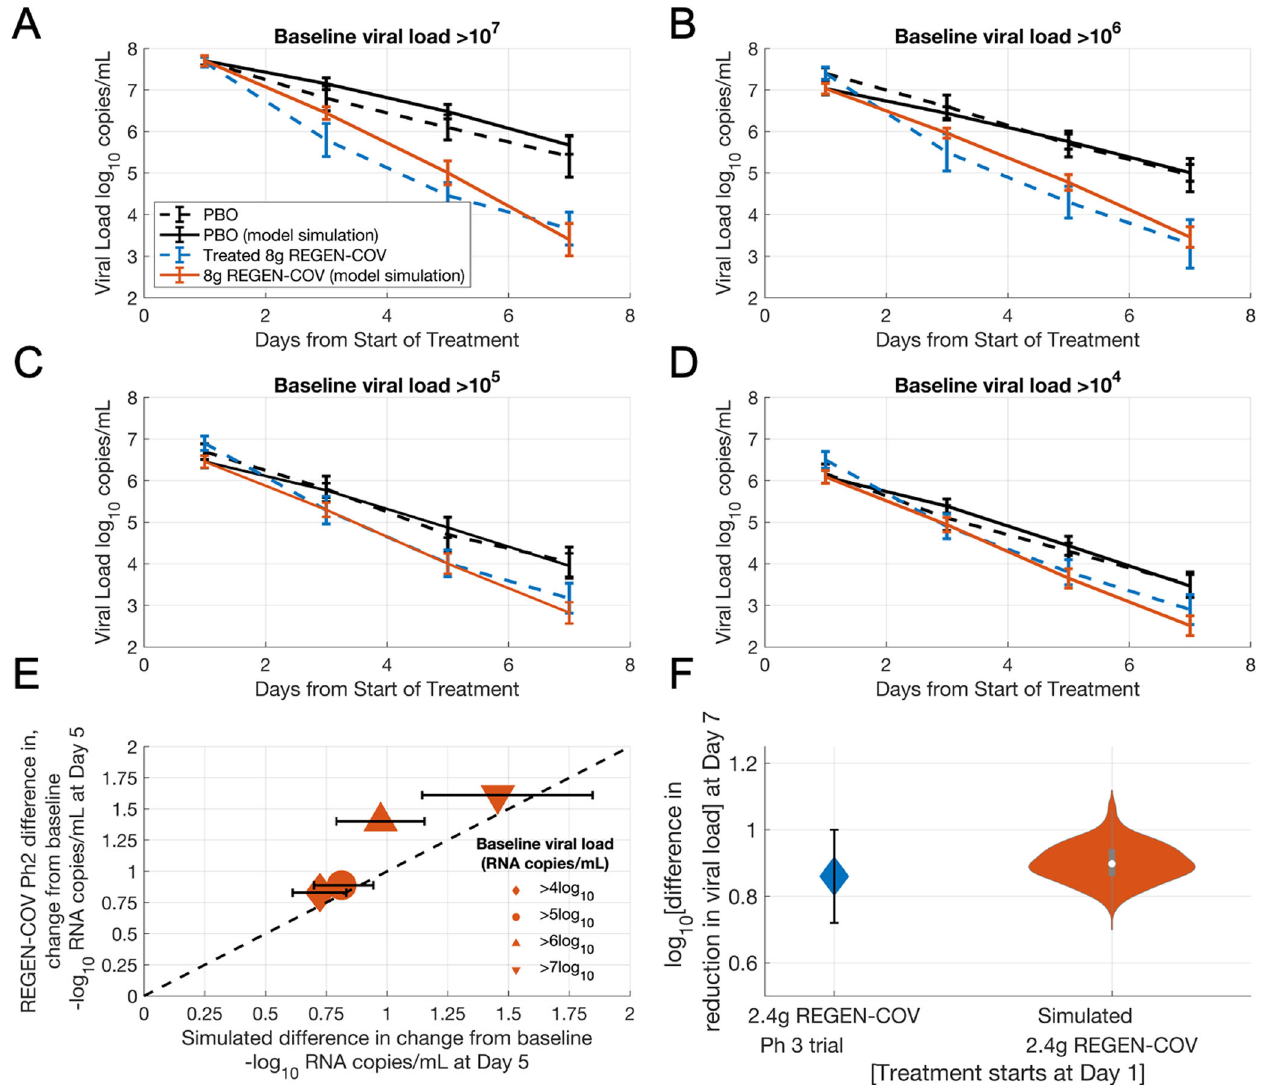
Fig. 4 Partial validation of the model against REGEN-COV antibody cocktail trial data. A – D Time course of the viral dynamics of the overall virtual population and each of the subgroups compared against observations from the REGEN-COV Ph2 clinical trial for the placebo group and the 8 g REGEN-COV treatment group. Error bars are representative of the standard error for the virtual population and clinical trial observations. E Log10 reduction in viral load from baseline at day 5 for the overall virtual population and each of the subgroups compared against observations from the REGEN-COV Ph2 clinical trial for the placebo group and the 8 g REGEN-COV treatment group. Error bars are representative of the 99% prediction interval of the mean for the virtual population. F Log10 reduction in viral load from baseline at day 5 for the overall virtual population compared against observations from the Ph3 trial REGEN-COV trial for the 2.4 g REGEN-COV treatment. Error bars are representative of the 95% con fi dence interval for clinical trial observations. Violin plots are indicative of 99% prediction interval of mean from 1000 bootstrapped samples of the virtual population. REGEN-COV Ph2 data extracted from 24 and REGEN-COV Ph3 data extracted from ref. 39